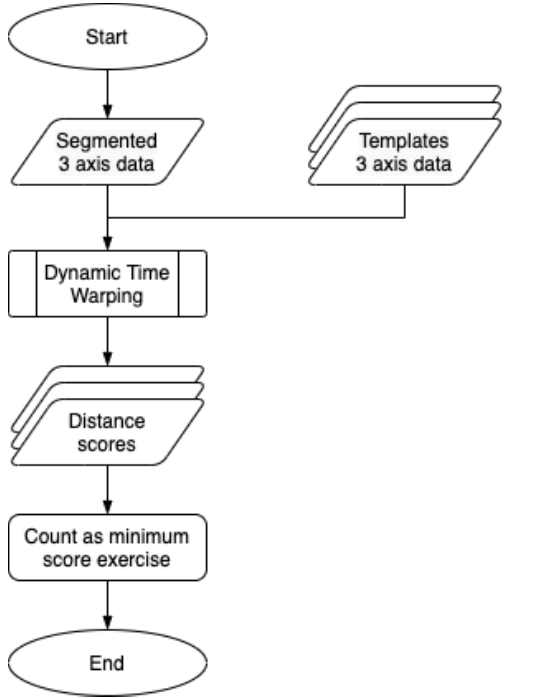
Figure 5. Flow chart of the processing flow of the proposed method to classification extracted motion signal